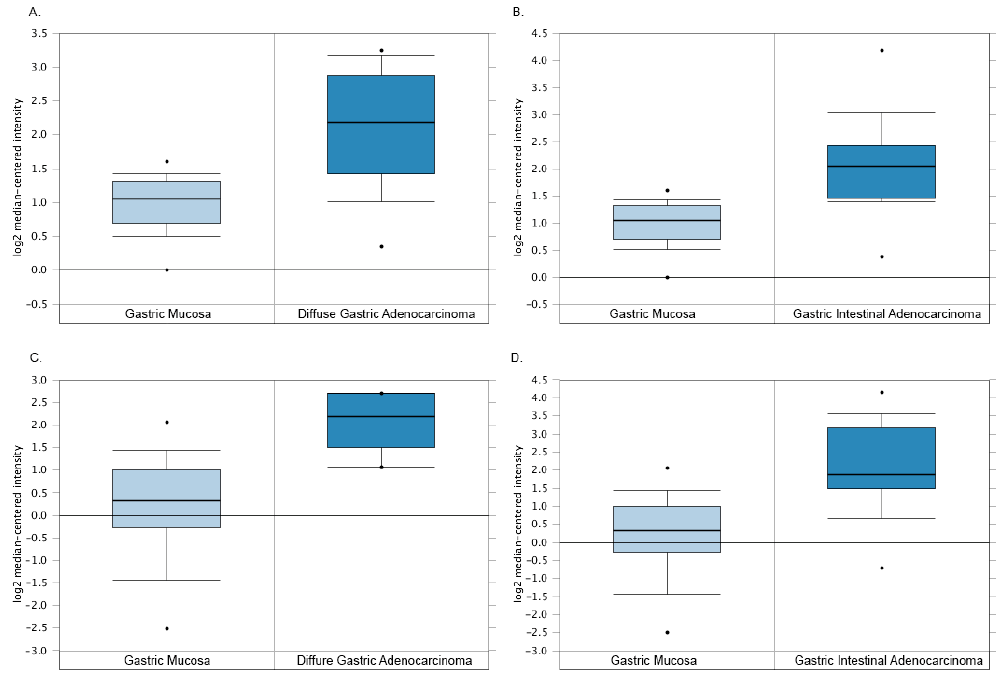
Figure 6. Comparison of TYMP gene expression in gastric mucosa with diffuse gastric adenocarcinoma ( A , C ) or gastric intestinal adenocarcinoma ( B , D ). p values < 0.0001 calculated by t -test analyzed through Oncomine.